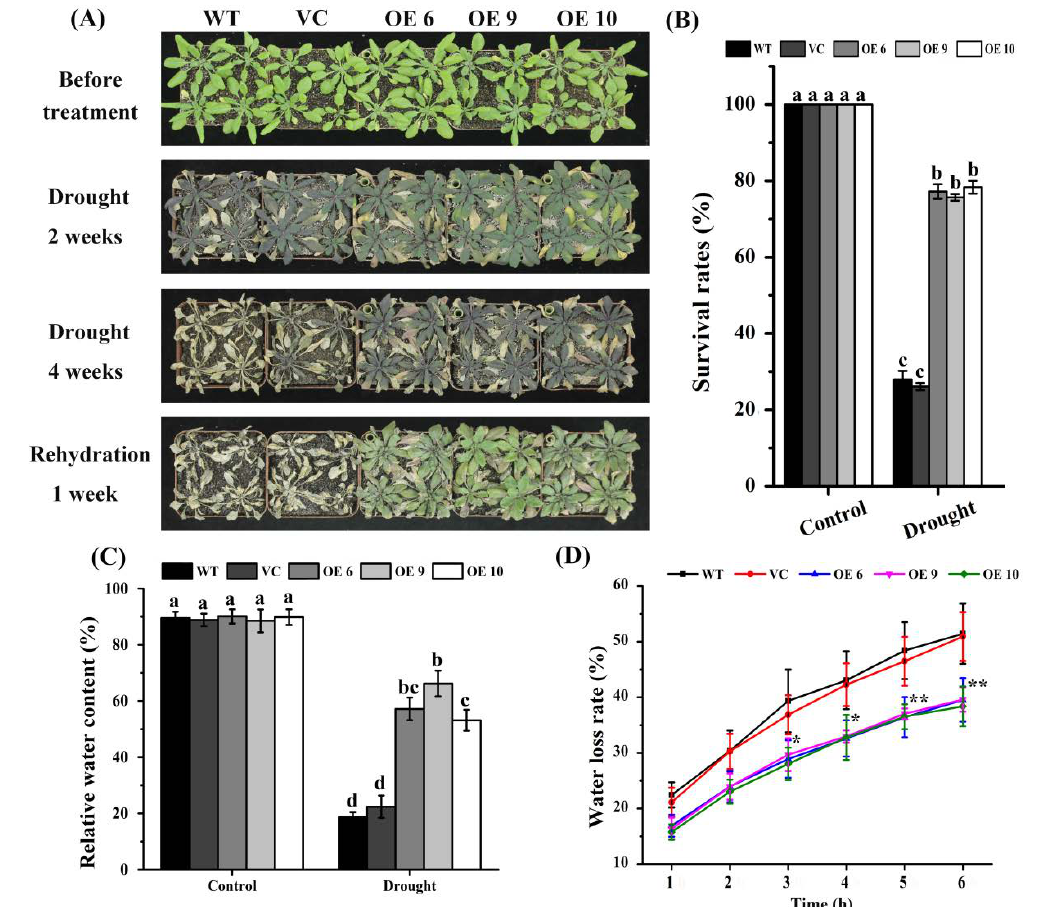
Figure 2. TaTIP4;1 overexpression improved drought tolerance in Arabidopsis . ( A ) Growth perfor- mances of plants. Four-week-old plants of Arabidopsis WT, VC, OE6, OE9 and OE10 were not watered for 2 and 4 weeks, respectively, and then rewatered for 1 week. ( B ) The survival rates of plants after drought stress for 4 weeks. ( C ) Relative water contents of leaves after drought stress for 4 weeks. Different lowercase letters show that the values from the plants significantly differed from each other by one way ANOVA and Tukey’s honestly significant difference test (Tukey’s HSD test) ( p < 0.05). ( D ) Leaf water loss rates of four-week-old plants. Single and double asterisk indicate that the values of TaTIP4;1 overexpressors significantly differed from WT and VC plants at * p < 0.05 and ** p < 0.01 levels respectively by student’s t test. Data are mean ± SD (n ≥